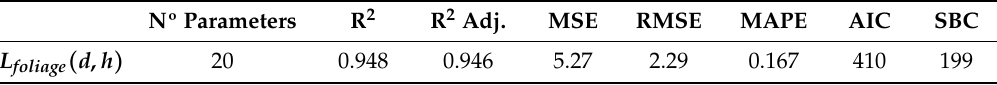
Table 3. Evaluation parameters of the regularised optimisation carried out for 20